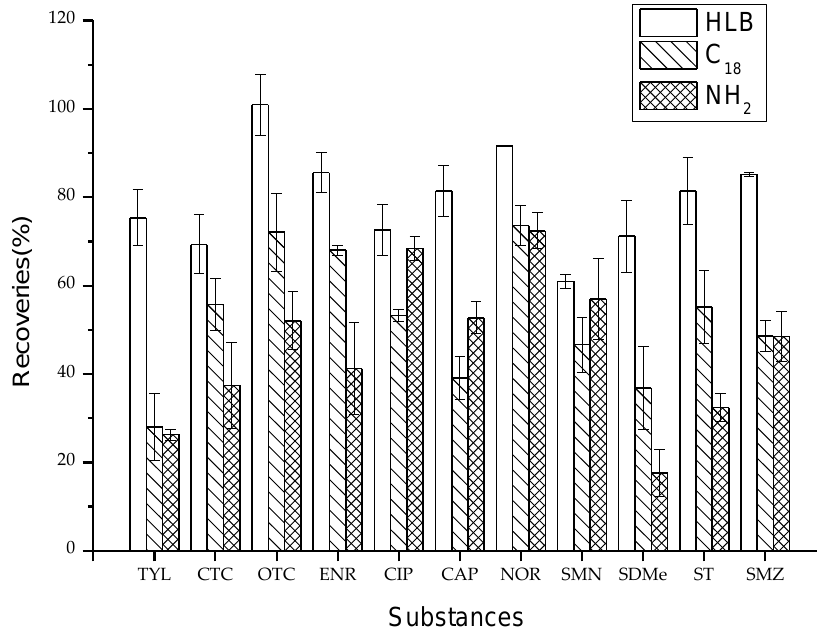
Figure 2. Comparison of 11 antibiotics recoveries from three different SPE cartridges for